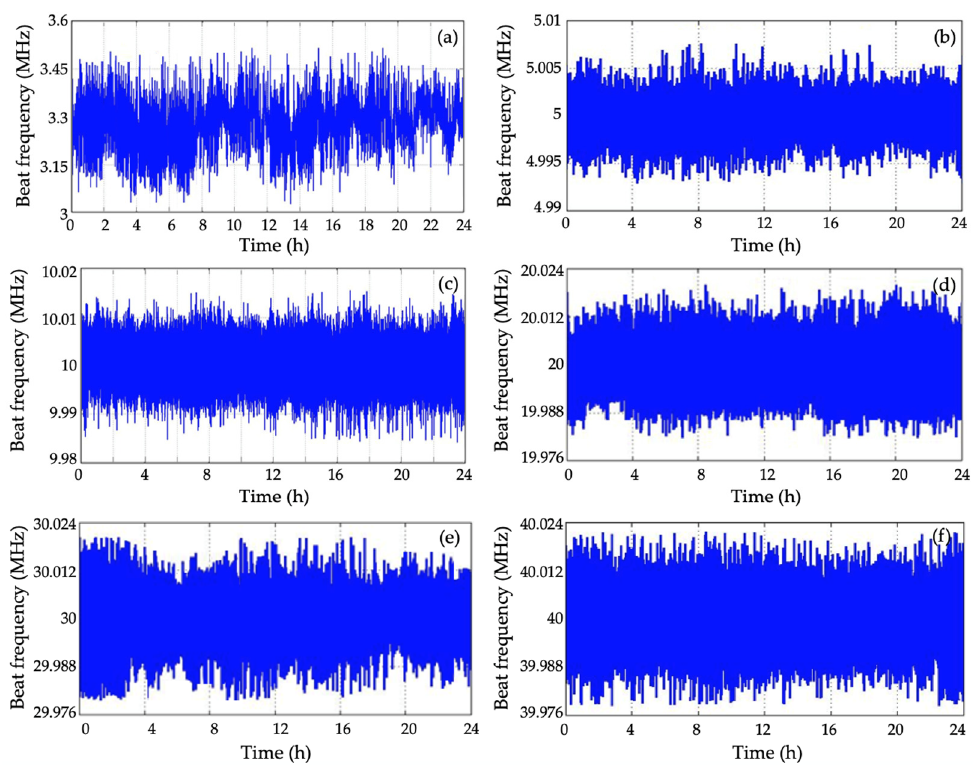
Figure 5. Beat frequency results over 24 h: ( a ) When the slave laser runs without offset-locked controlling, and when the offset-locked frequency is ( b ) 5, ( c ) 10, ( d ) 20, ( e ) 30, and ( f ) is 40 MHz.